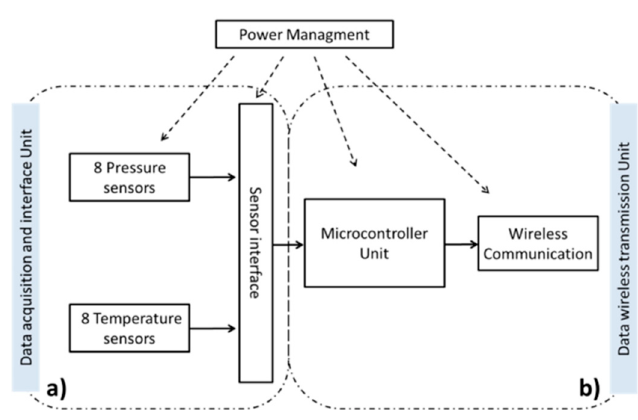
Figure 1. Overview of the Insole hardware architecture. ( a ) temperature and pressure parameters acquisition and ( b ) elaboration and transmission data.